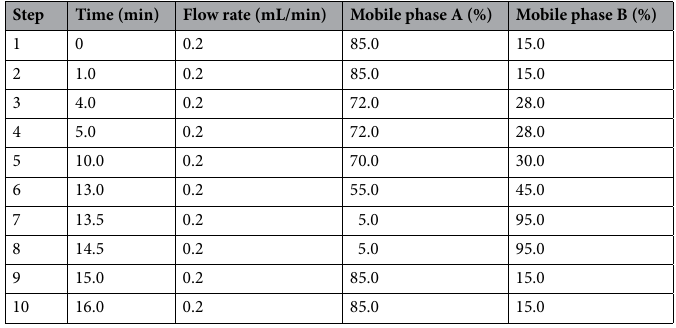
Table 1. Steps of gradient